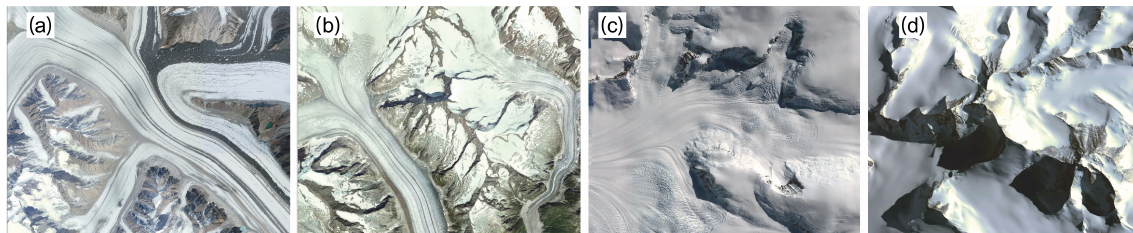
Figure 4. Comparison of debris cover for glaciers at low latitudes: (a) Karakoram Range (35 ◦ N) and (b) Jungfrau Range, Alps (46 ◦ N), with those of Antarctica (c) , the Antarctic Peninsula (66 ◦ S) and (d) Transantarctic Mountains (72 ◦ S). Note the lack of surface moraine and the deep shadows in (c) and (d) , typical of Antarctic glaciers where a lack of day–night cycle and year-round low temperatures restricts freeze–thaw action and the permanently low sun angles result in deep shadows in remotely sensed